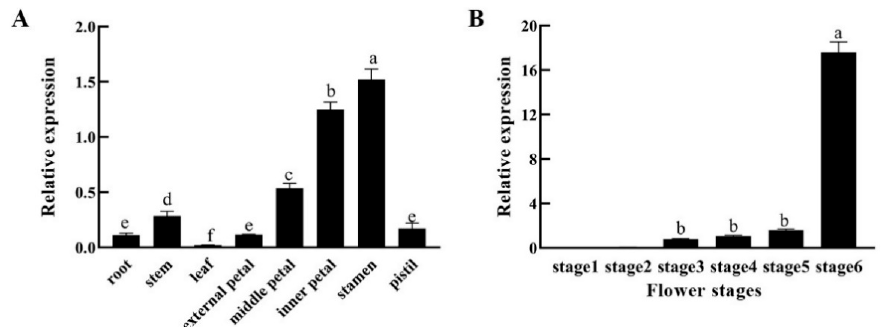
Figure 3. Expression patterns of CpSRG1 in wintersweet. ( A ) Relative expression of CpSRG1 gene in different tissues of wintersweet. ( B ) Expression of the CpSRG1 gene at different flower stages of wintersweet. Stage 1 (sprout period); stage 2 (flower-bud period); stage 3 (petal-display period); stage 4 (initiation of bloom period); stage 5 (bloom period); stage 6 (withering period). CpActin and CpTublin were used as an internal control. Data represent the mean of three biological repeats ± SEM. Error bars indicate the standard error of the mean. Different lowercase letters (a–f) on bars indicate significant differences ( p < 0.05).